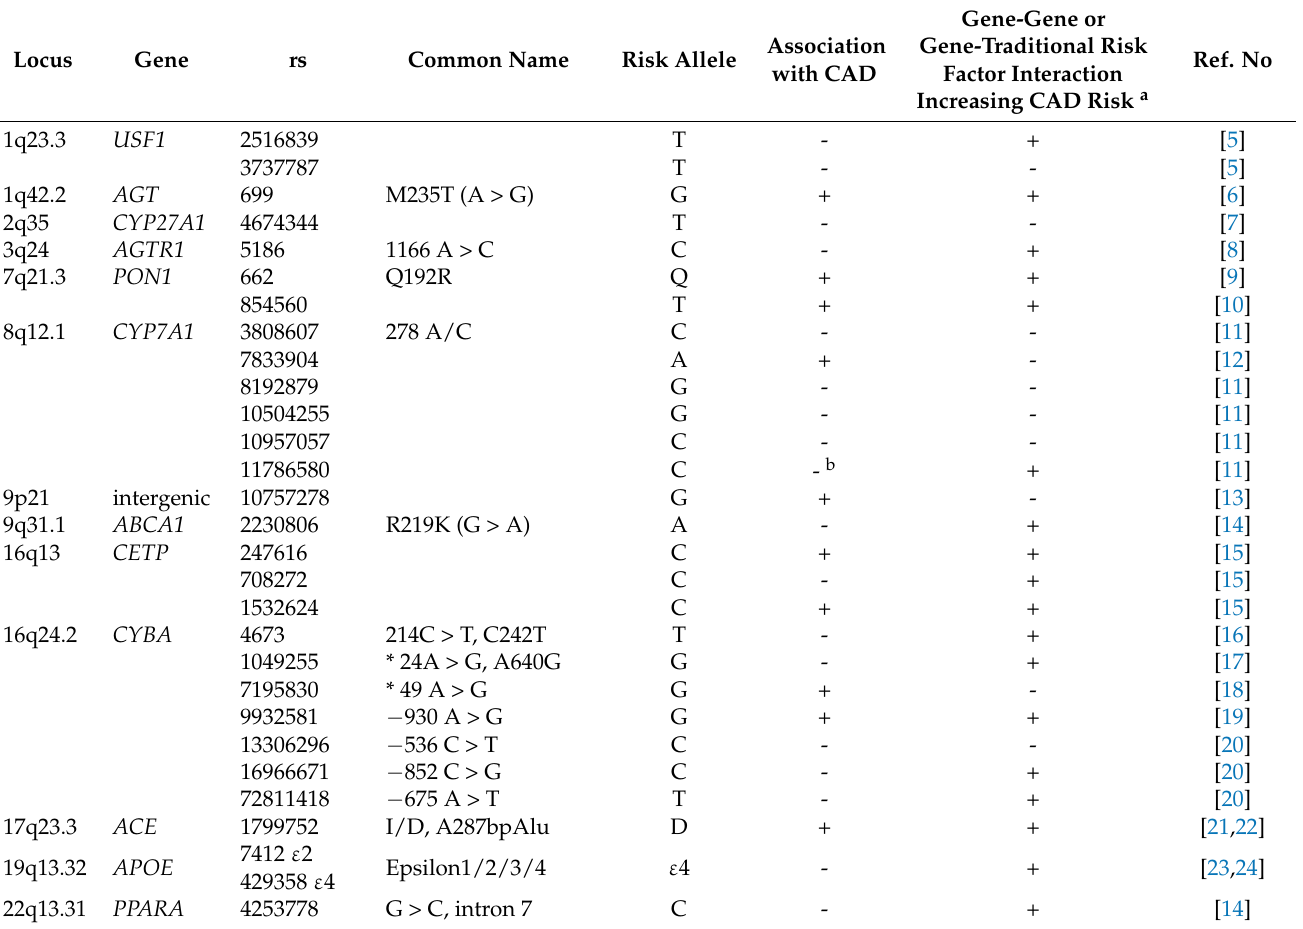
Table 1. Analyzed polymorphisms in patients with CAD from Upper Silesia